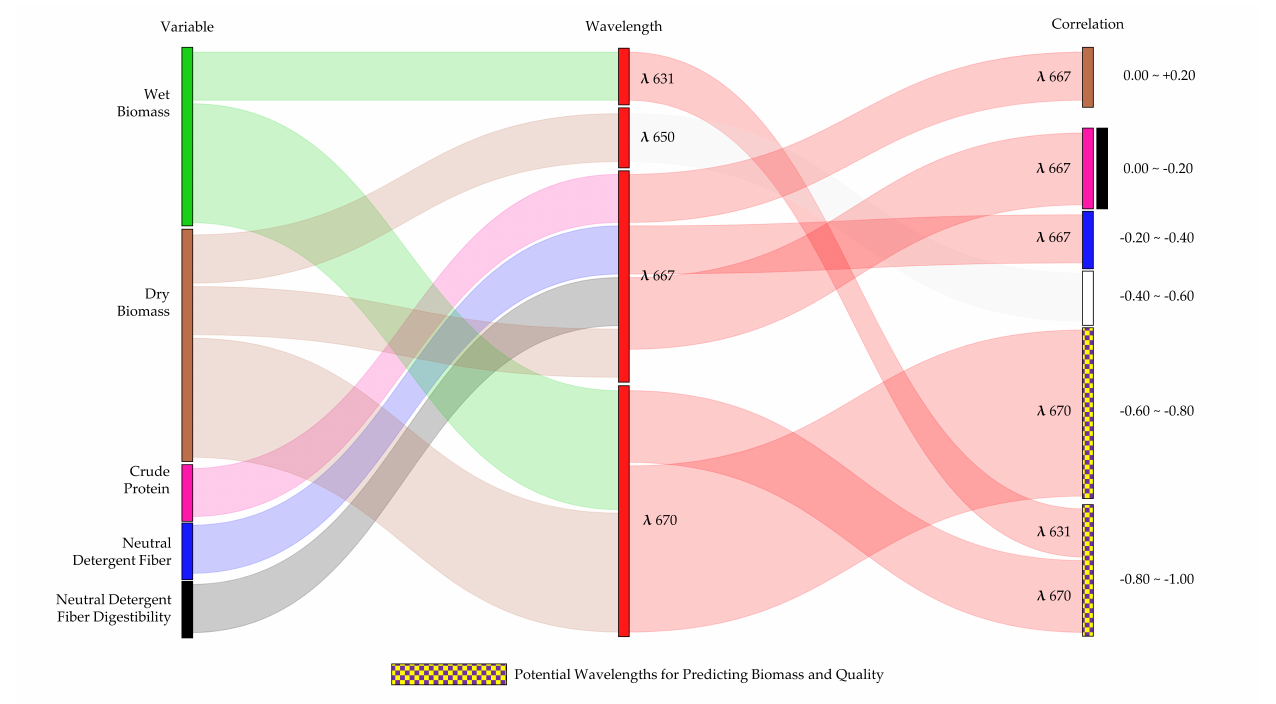
Figure A3. Sankey diagram illustrates the wavelengths in the red region ( λ 620 − 670) most correlated with alfalfa biomass and quality traits. The flow chart intuitively displays bars and paths drawn in proportion to the amount of information used. The larger the bars, the more times this information has been used. Colored pathways assign the connections between alfalfa biomass and quality traits and its usage in remote sensing data (i.e., wavelengths or vegetation indices) as well as its response to the strength of the correlation. When wavelength or vegetation indices have the potential to be used to establish a relationship with biomass and quality traits, they are marked. The colors of each correlation bar are linked to the biomass and quality traits. When it is white, it is because it has no potential to be used. However, when the bar is colored and checkered, it indicates that although it has not been used to study its relationship with quality, it has the potential to predict it assuming its correlation with